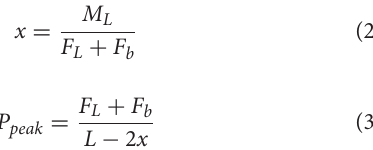
FIGURE 9 | Model of hand dorsum and PHRII with minimized pressure distribution, bias force ( F b ), externally applied force ( F L ), moment load ( M L ) and resulting two regions of optimal reaction pressure ( P opt )